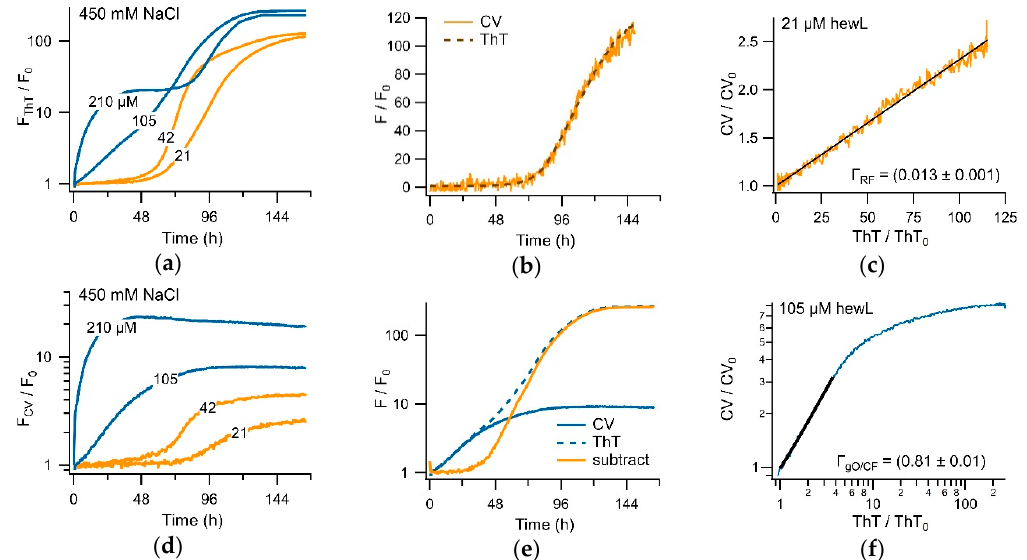
Figure 7. Correlation of CV and ThT kinetics. ( a , d ) HewL amyloid formation (pH 2, 450 mM NaCl, T = 52 °C) at concentrations below (orange) and above (blue) the COC, simultaneously monitored with ( a ) ThT (15 μ M) and ( d ) CV (5 μ M). The traces are the average of the three recordings from separate wells. ( b , e ) Superposition of the CV (solid lines) and ThT (dashed lines) responses, after matching the CV data using the Γ -factor determined in ( c ) and ( f ), respectively. Subtracting the matched CV from the ThT trace yields the orange sigmoidal trace in ( e ). ( c , f ) Correlation of the fractional changes of CV versus ThT responses during ( c ) sigmoidal versus ( f ) biphasic growth kinetics. The Γ -coefficient indicates the ratio of the CV versus ThT response amplitude in the linear regime of each plot.